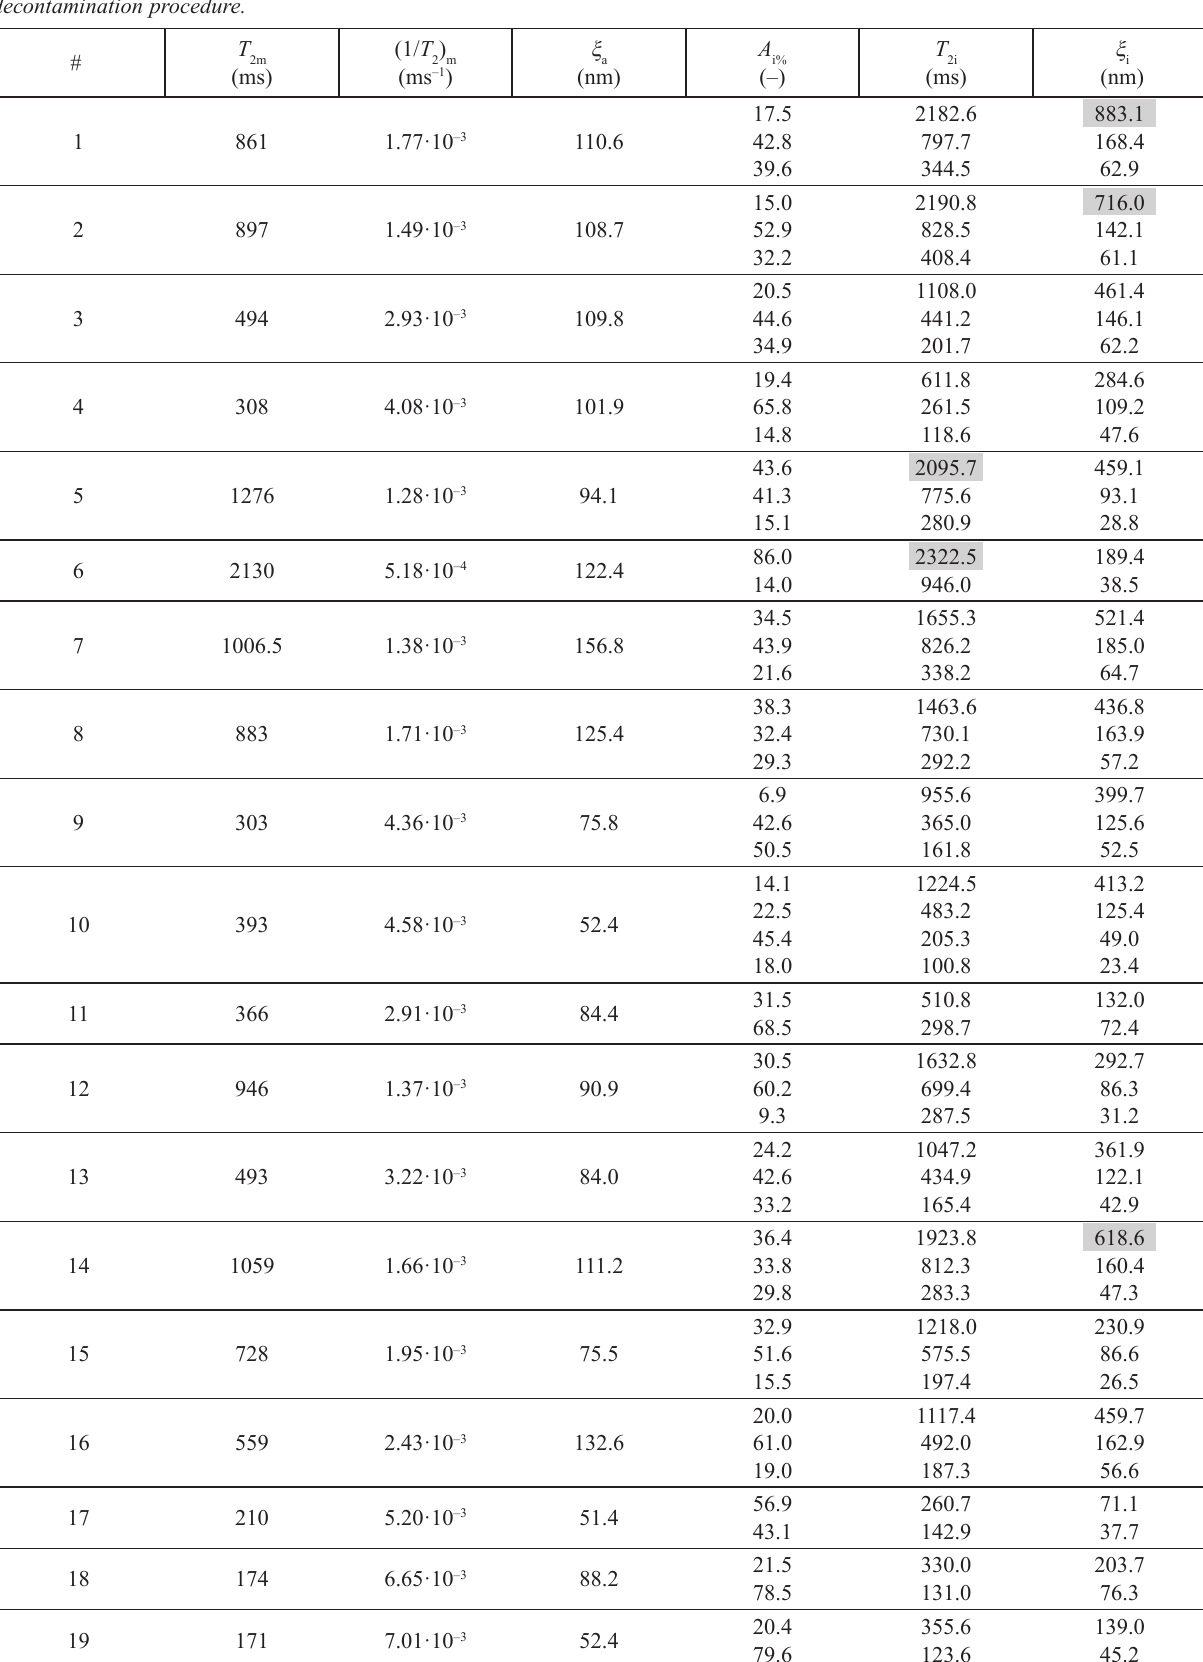
Table 2 – Average relaxation time (T age fraction